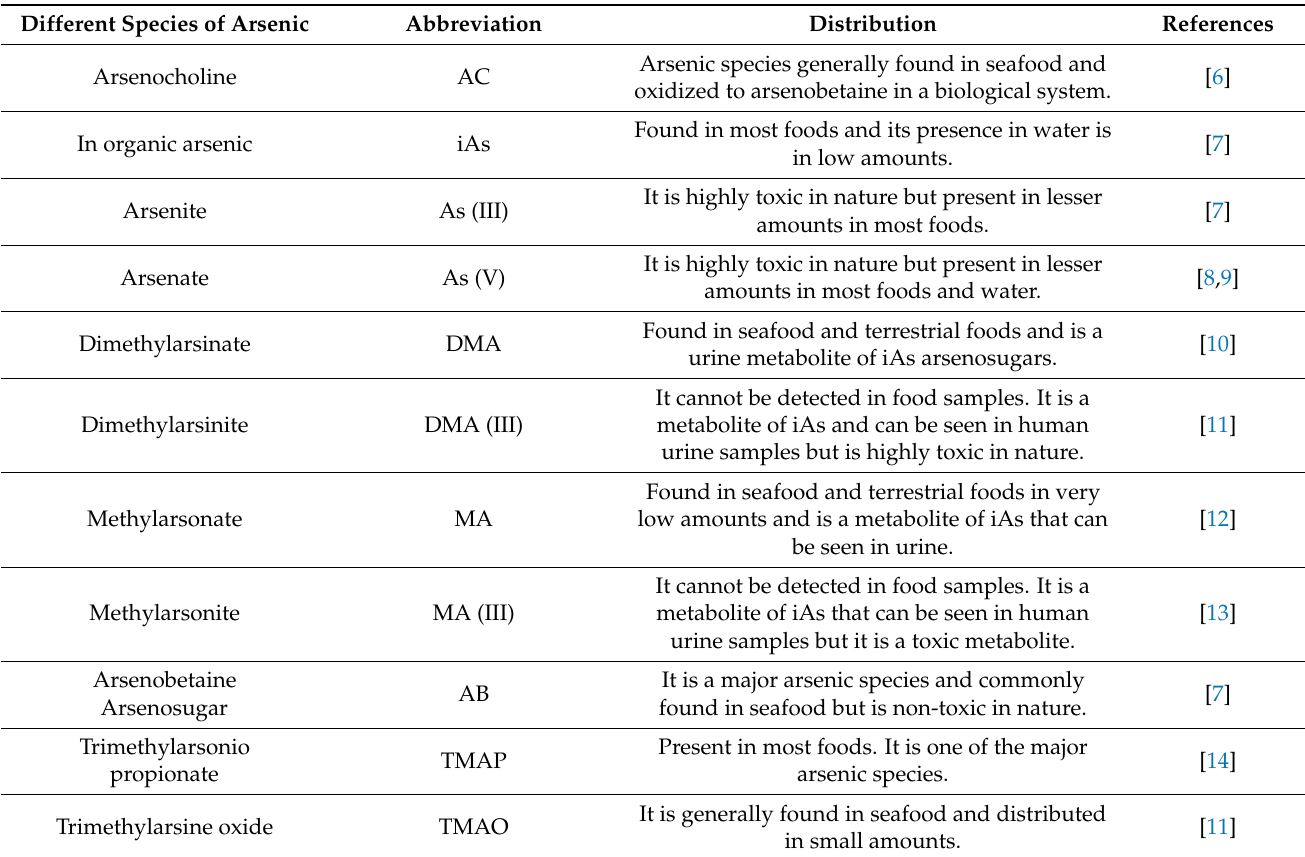
Table 1. Different species of arsenic and their distribution in various foods with